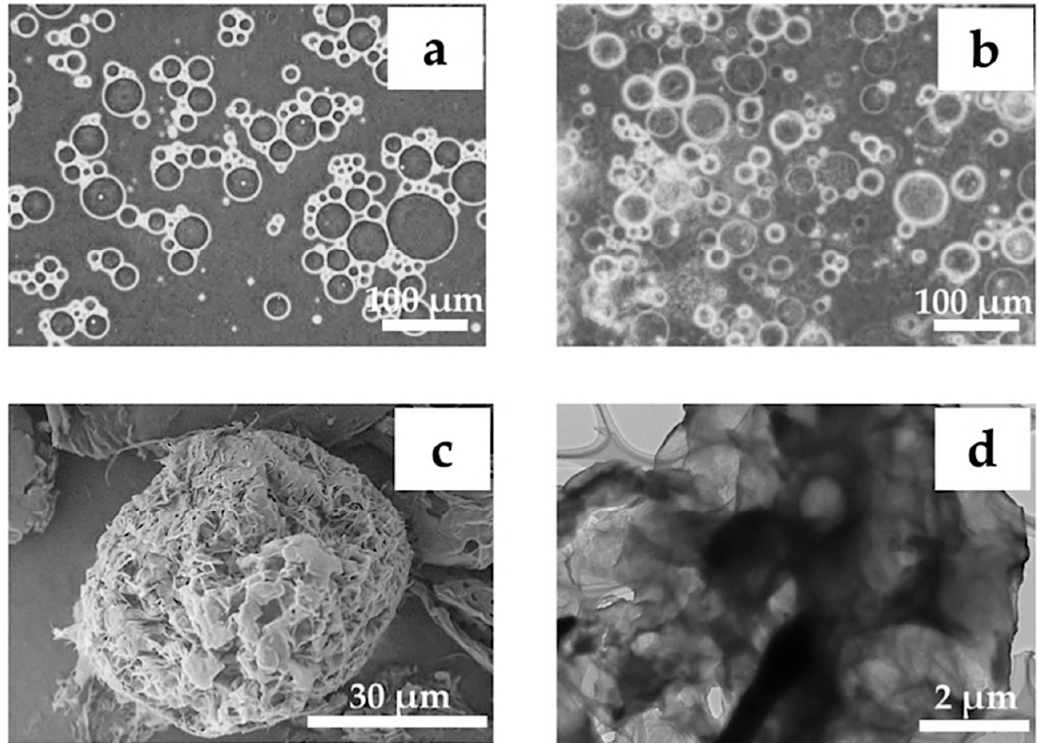
Figure 8. Optical microscopic images of reverse micelles in emulsion ( a ) and microgels ( b ) prepared under 3 % w / w chitin solution, O:W = 15:1, 5% w / w Span 80 (HLB 4.3), and gelation by 800 µ L of 1.0 M HCl. Morphologies of the freeze-dried microgels are shown at magnifications of 2,000 × by scanning electron microscopy (SEM) ( c ) and 4,000 × by transmission electron microscopy (TEM) ( d ).